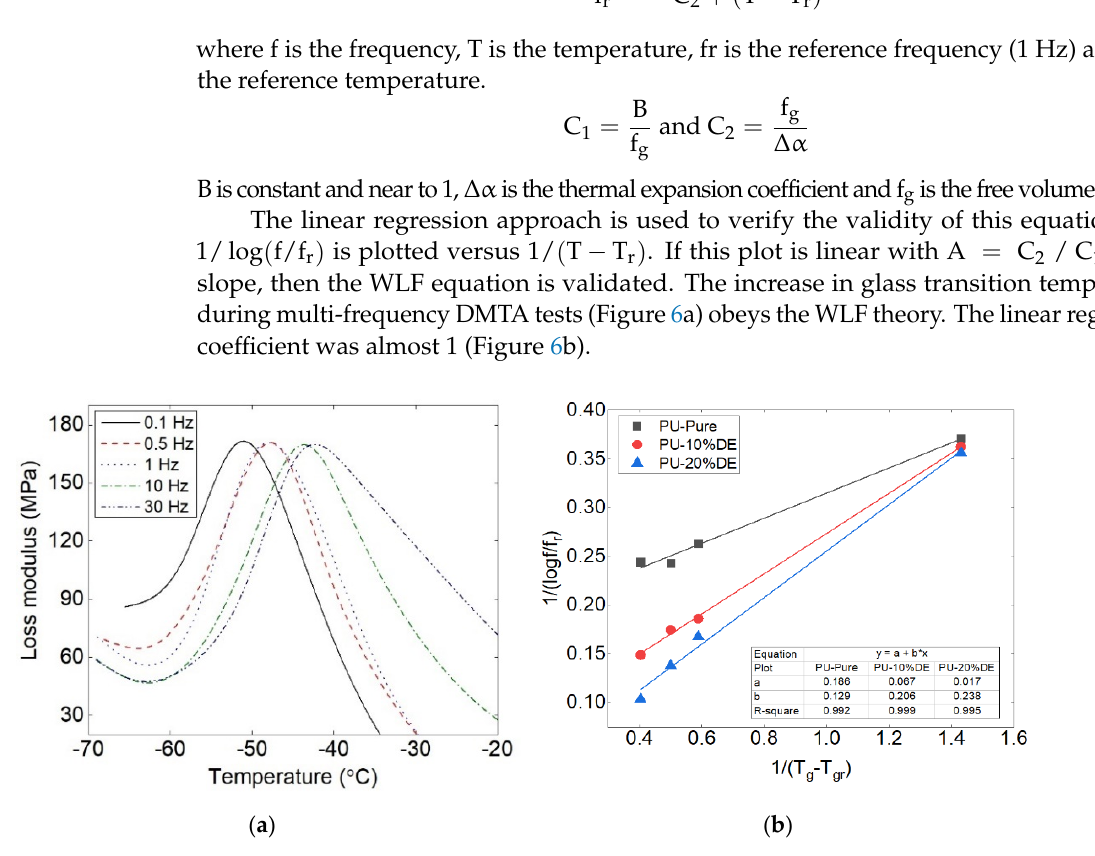
Figure 6. ( a ) Multi-frequency DMTA tests: glass transition temperature evolution (PU-10% DE) and ( b ) linear regression of WLF equation.